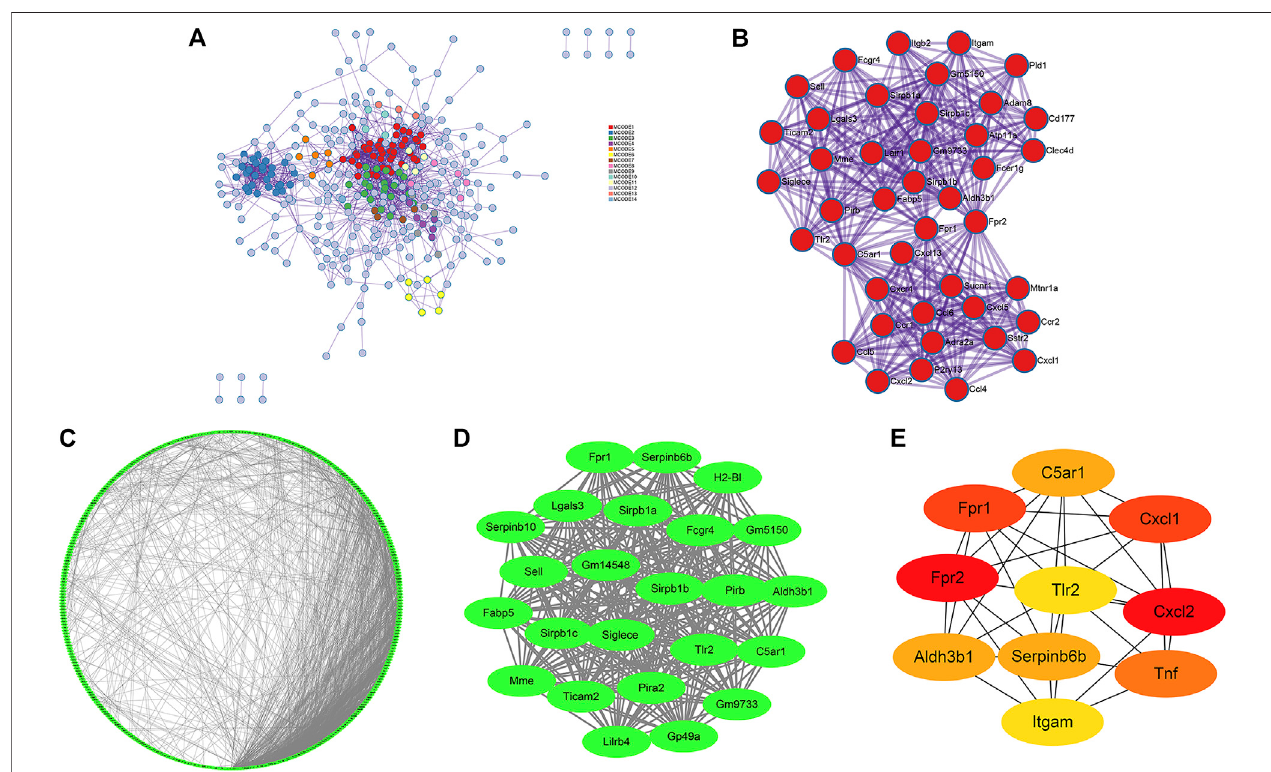
FIGURE 4 | PPI network, signi fi cant modules and hub gene networks constructed through Metascape (A, B) , STRING (C) , and Cytoscape (D, E) . (A) A PPI network of DEGs including 14 MCODE modules was established via Metascape. (B) The Metascape_MCODE1 consists of 42 genes. (C) A PPI network of DEGs consistingof1937edgesand443nodeswasestablished via STRINGwithacon fi dencescoreof ≥ 0.7forsigni fi cantdifferences. (D) TheCytoscape_MCODE1consists of 24 genes. (E) Ten genes were identi fi ed as hub genes with Cytoscape_cytoHubba.